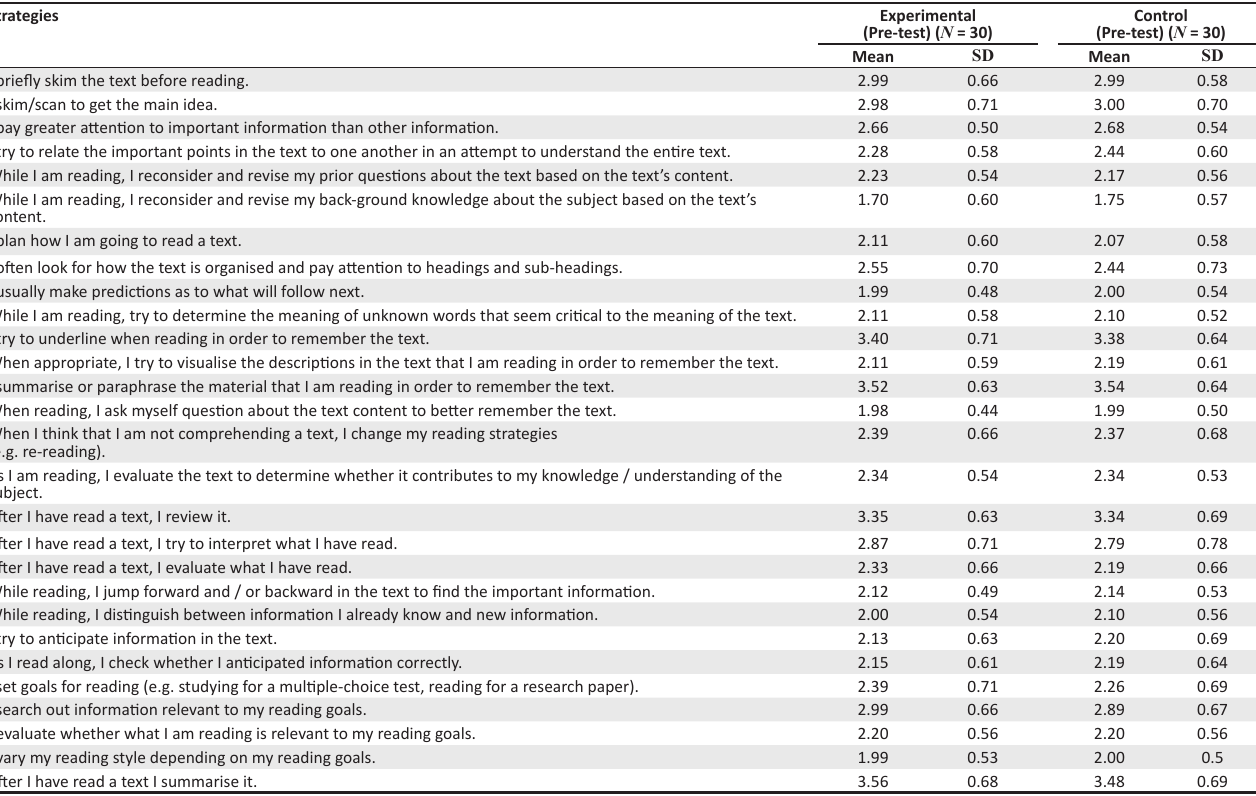
TABLE 1: The pre-test reading strategy use profile of Grade 11 ESL learners: Experimental group versus control group. Strategies Experimental